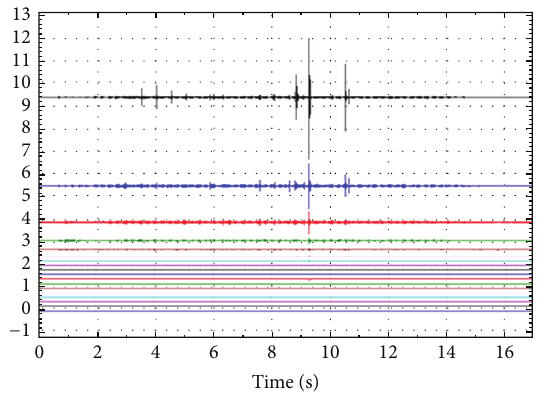
Figure 28: EEMD analysis results of effective microseism signals from 4# sensor in working condition 29.